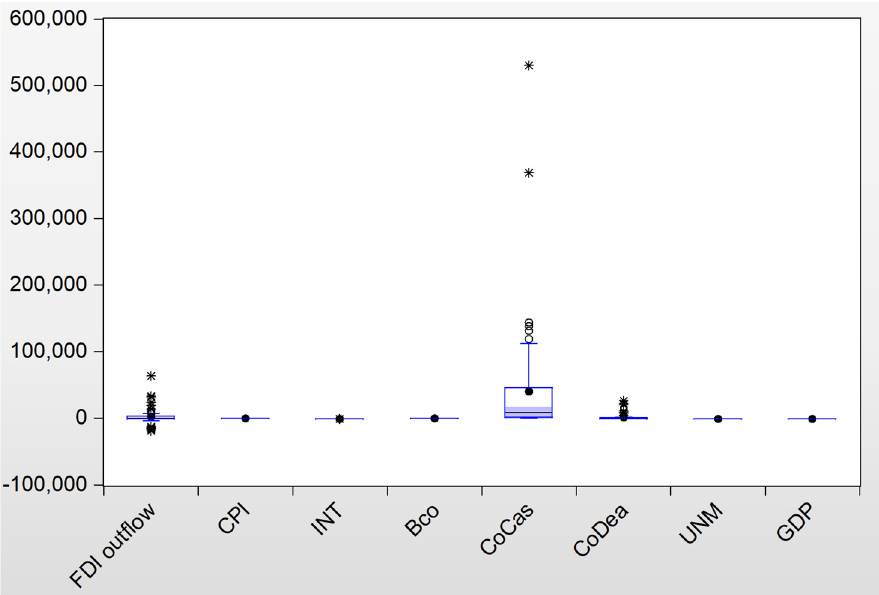
Figure 5. Visualized summary statistics with boxplots.